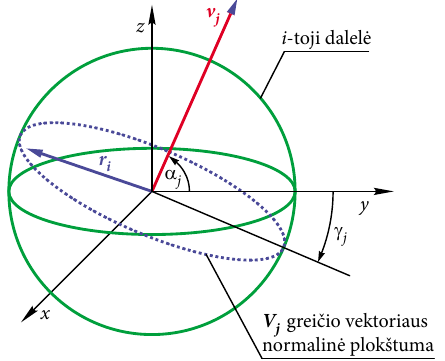
– i -tosios normalinės plokštumos orientacija (čia r j dalelės spindulio vektorius) Fig. 18. Orientation of the 26 points normal plane of the (here, r is the radius velocity vector of the i th particle v j j vector of the i th particle